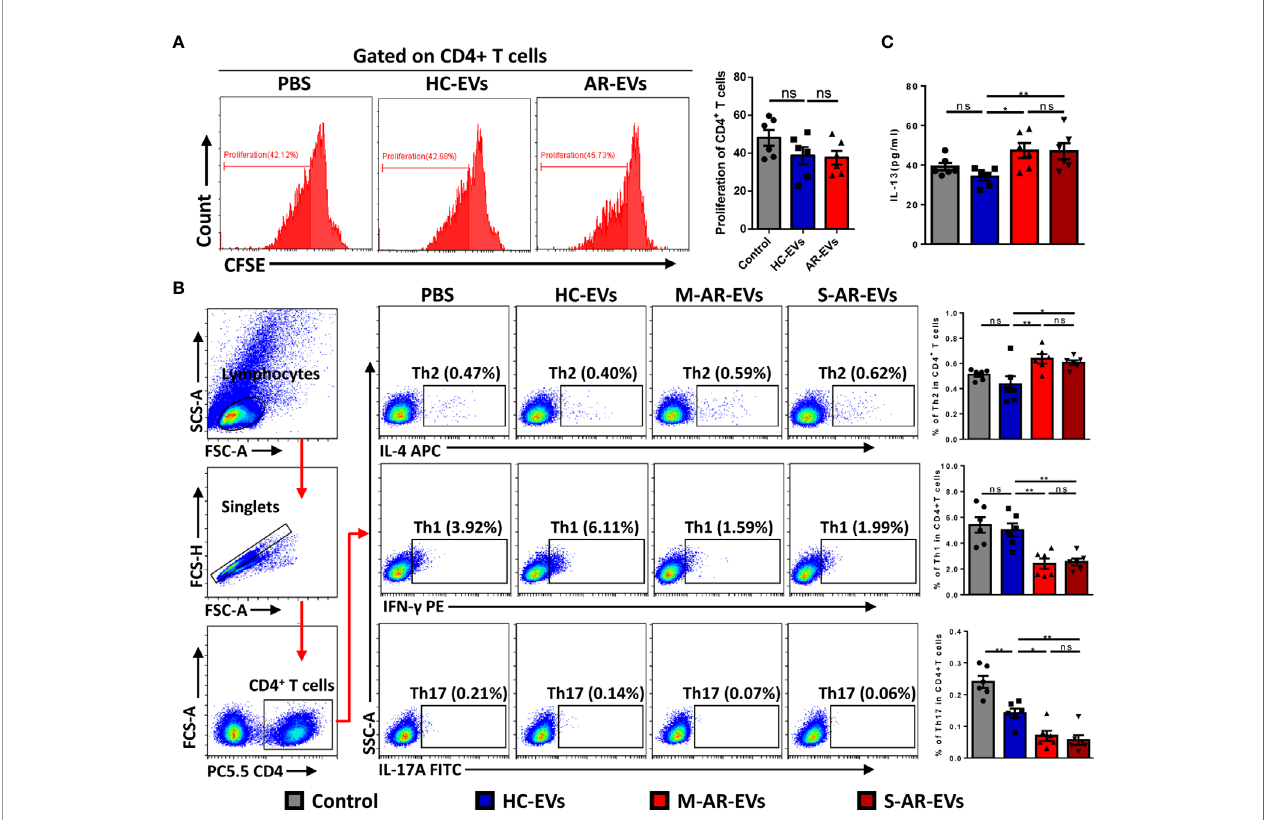
FIGURE 5 | Effects of plasma EVs isolated from AR patients on the differentiation of T helper cells in PBMCs. (A) Flow cytometry analysis showed that no signi fi cant difference was observed on the proliferation of CD4 + T cells after treated with HC-EVs and AR-EVs. (B) Level of Th2 was increased in PBMCs treated with M-AR- EVs and S-AR-EVs compared with those treated with HC-EVs, while levels of Th1 and Th17 were oppositely reduced by M-AR-EVs and S-AR-EVs. (C) Level of IL-13 was signi fi cantly increased in the supernatants of AR-EV-stimulated PBMCs. EVs, Extracellular vesicles; HC, Healthy control; M-AR, Mild allergic rhinitis; S-AR, Moderate-severe allergic rhinitis; Th1, type 1 T helper cells; Th2, type 2 T helper cells; Th17, type 17 T helper cells; ns, no signi fi cance. Flow cytometry analyses of T helper cells and ELISA for IL-13 were analyzed by Mann – Whitney U test. Flow cytometry analyses of proliferation were analyzed by one-way ANOVA multiple comparison. * p < 0.05, ** p < 0.01. The data were combined from two independent